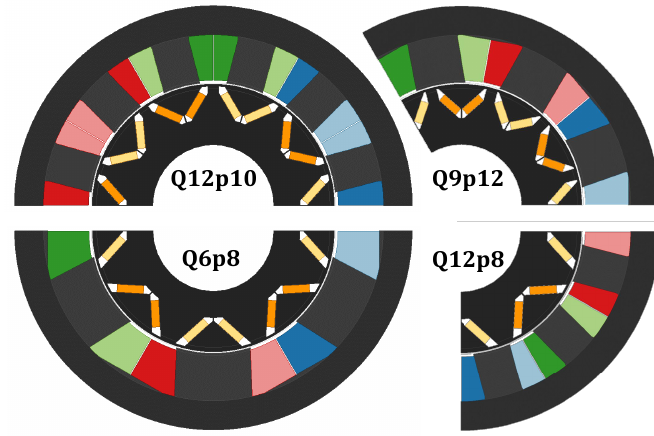
Figure 1. Smallest unique section of rotor and stator geometries for the four tooth-coil winding machine (TCWM) slot-pole combinations evaluated through FEA.